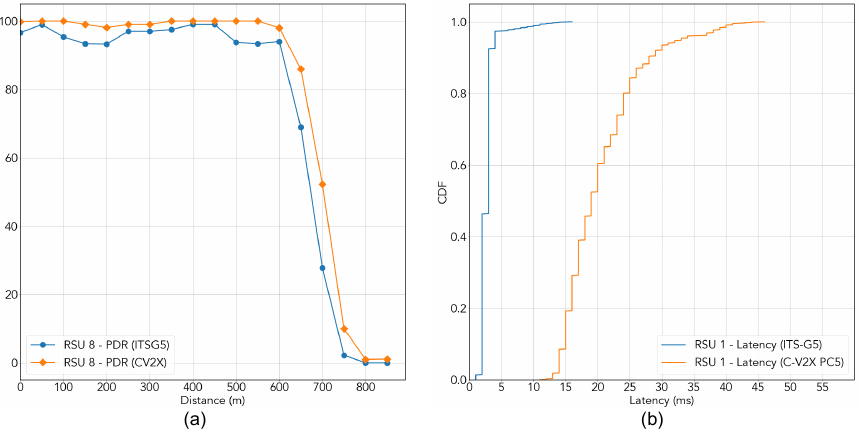
Figure 6. ( a ) Packet Delivery Rate (PDR) and ( b ) one way latency for ITS-G5 and C-V2X PC5 from RSU to vehicle on the highway at the Belgian pilot